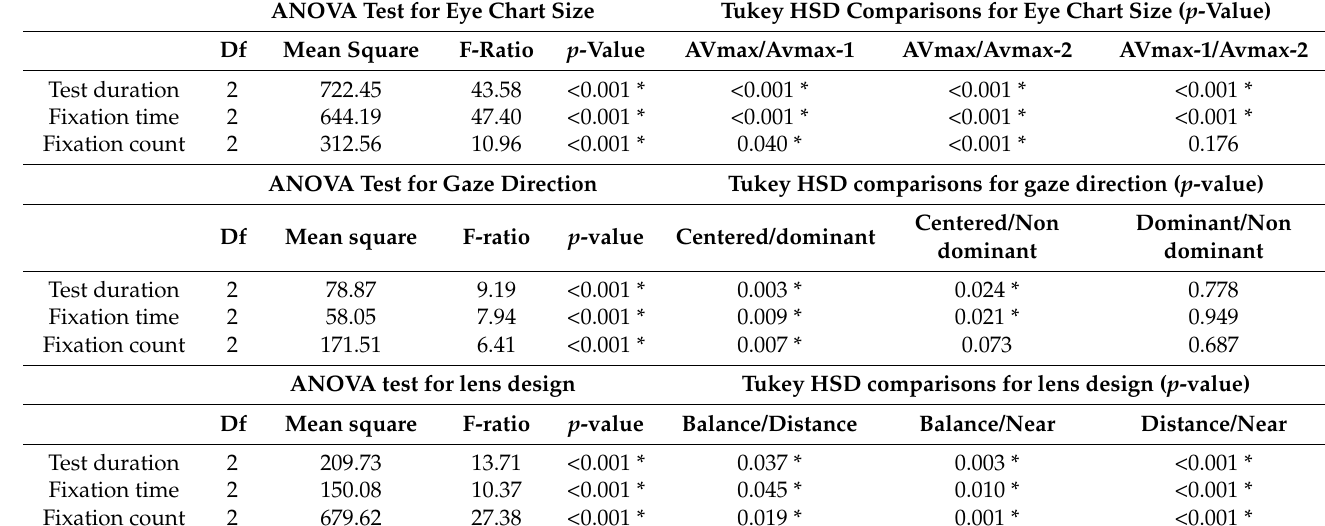
Table 4. Detailed statistics for Figure 5. Three-way repeated measures ANOVA test with pos-hoc comparisons using Tukey HSD method. * Shows significance at the 0.05